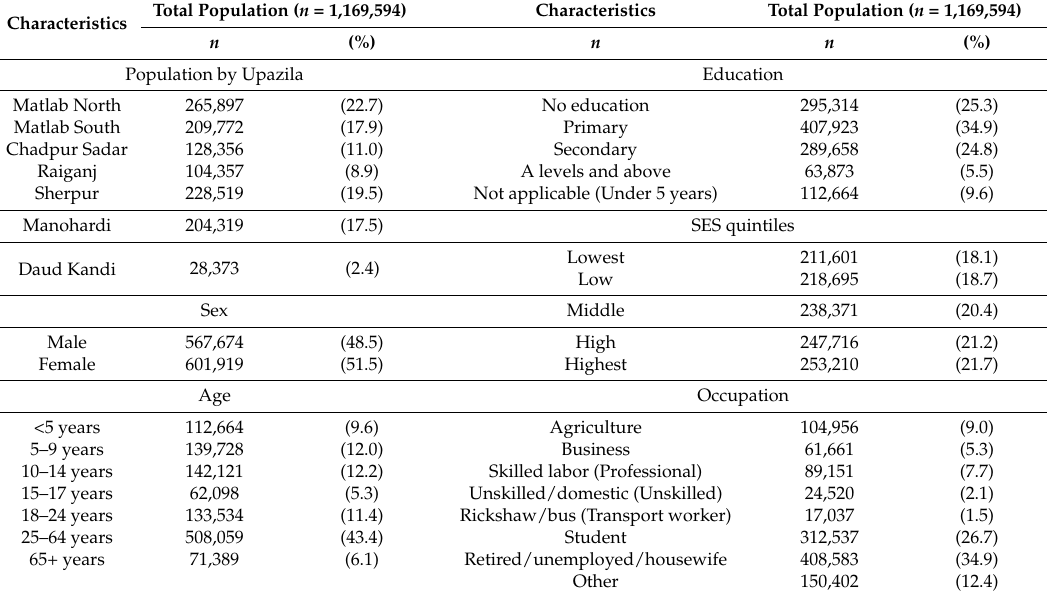
Table 1. Sociodemographic characteristics of fatal and non-fatal road traffic injury (RTI) outcomes.